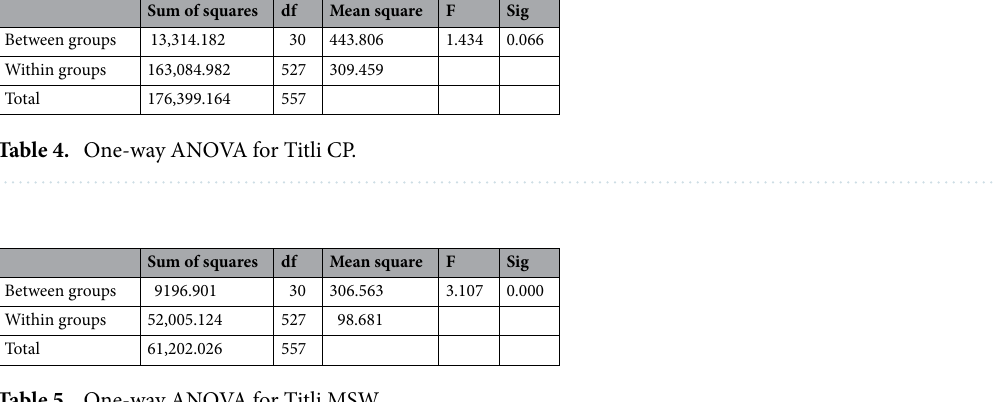
Table 5. One-way ANOVA for Titli